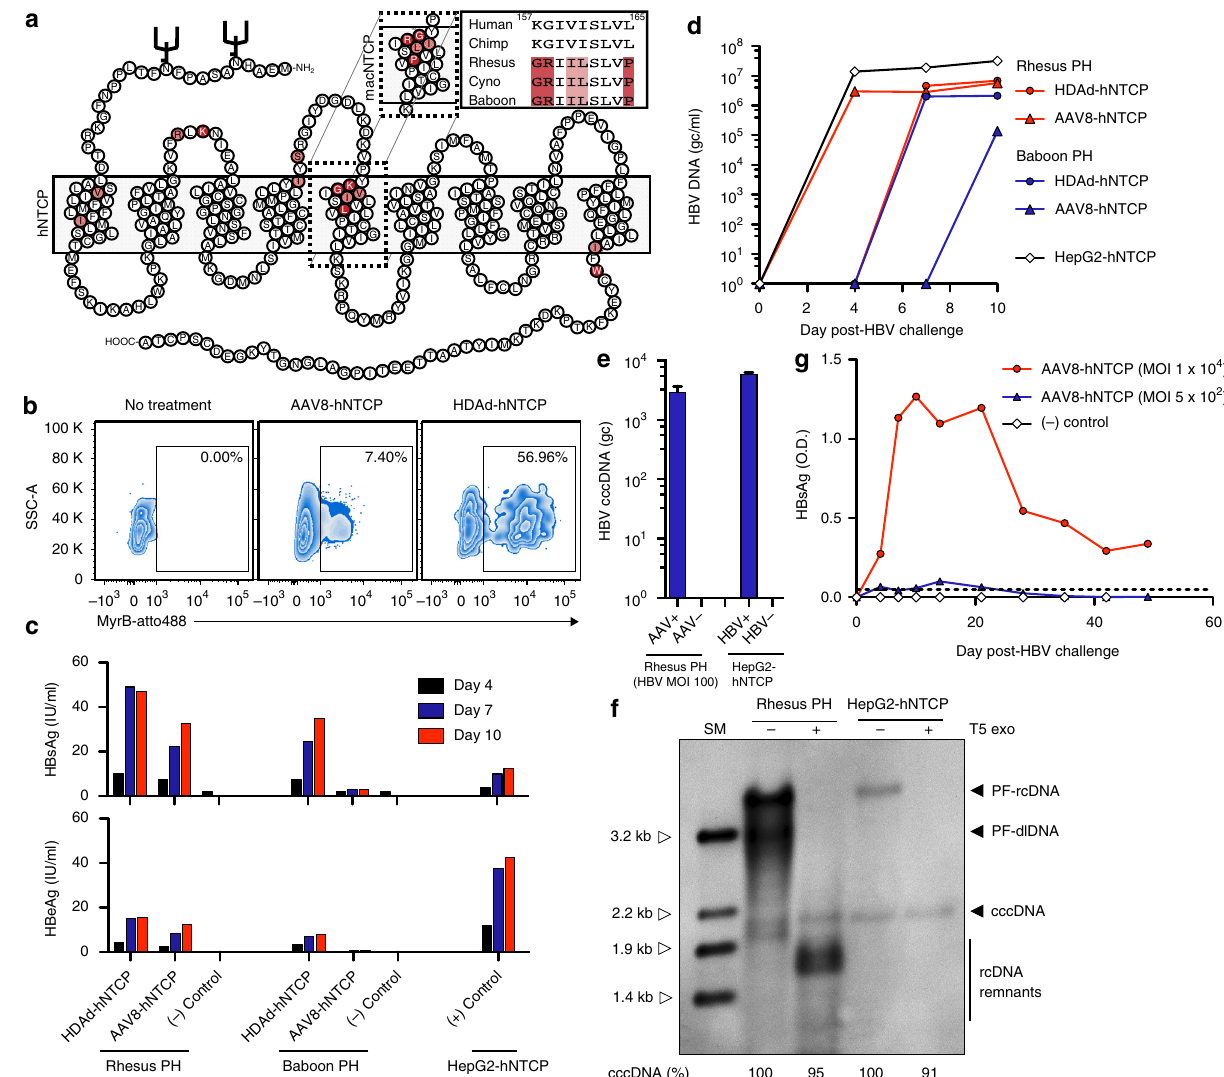
Fig. 2 In vitro HBV infection of rhesus macaque PH. a Predicted schematic of NTCP showing amino acid differences between human and macaque NTCP. Differences in the sequences were labeled with lighter red for amino acid exchanges with similar physiochemical properties and darker red for exchanges with different physiochemical properties. Gray box represents cellular membrane. N-linked glycosylation sites represented by black brackets. macNTCP = macaque NTCP. b Rhesus macaque PH were transduced with either HDAd-hNTCP (MOI = 2) or AAV-hNTCP (MOI = 1 × 10 4 ) and stained 3 days later with Myrcludex B-atto488. c Rhesus macaque and baboon PH were transduced with either HDAd-hNTCP (MOI = 2) or AAV-hNTCP (MOI = 1 × 10 4 ) and infected with HBV (MOI = 100) 3 days later. Productive infection was monitored by quanti fi cation of HBsAg and HBeAg in the supernatant by ELISA. Each condition represents a single-biological sample ( N = 1). Figure is representative data of two separate experiments. d HBV DNA qPCR on the same supernatants shown in c . Each condition represents a single-biological sample ( N = 1). e Total intracellular DNA from 1 × 10 6 rhesus macaque PH and HepG2-hNTCP cells was used in a cccDNA-speci fi c qPCR. Rhesus macaque PH transduced with AAV-hNTCP (MOI = 1 × 10 4 ) and infected with